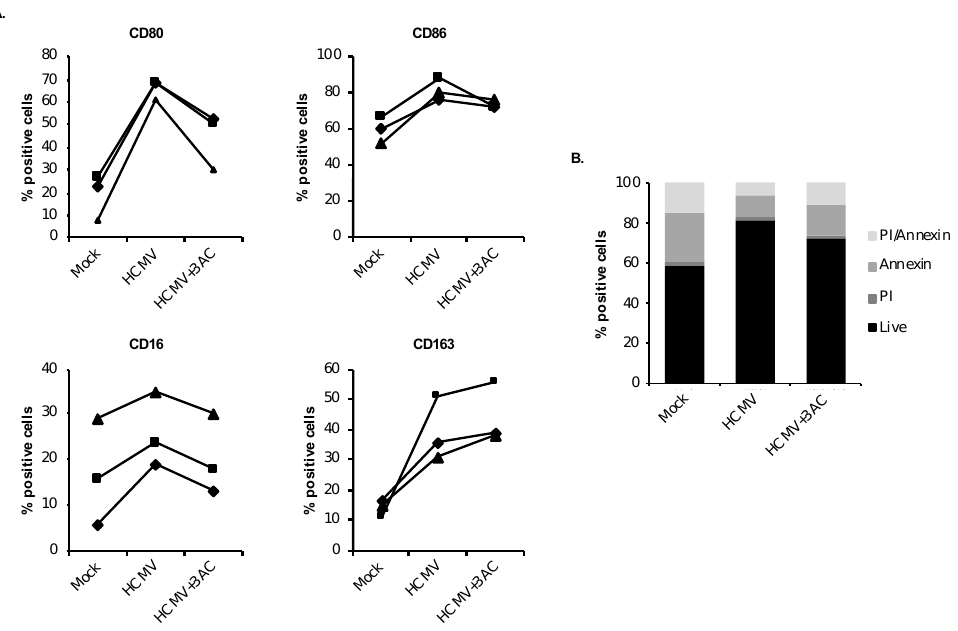
Figure 4. HCMV engages SHIP1 to induce monocyte-to-macrophage differentiation. ( A ) Human peripheral blood monocytes were pretreated for 1 h with a SHIP1 inhibitor (3AC) at 10 μM. Cells were mock- or HCMV-infected for 48 h, and the percent of cells positive for M1 (CD80 and CD86) and M2 (CD16 and CD163) macrophage markers was measured by flow cytometry. ( B ) Monocytes were pretreated for 1 h with 3AC at 10 μM, then mock- or HCMV-infected for 48 h. Viability was measured through PI and annexin V staining by flow cytometry. ( A , B ) Results are representative of 3–6 independent experiments using monocytes from different donors.